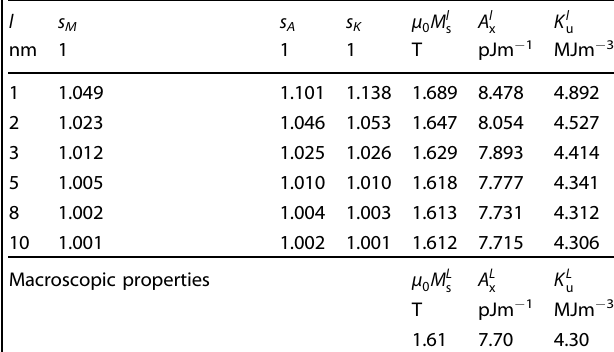
The macroscopic intrinsic properties from experiments are shown at the bottom of the table.